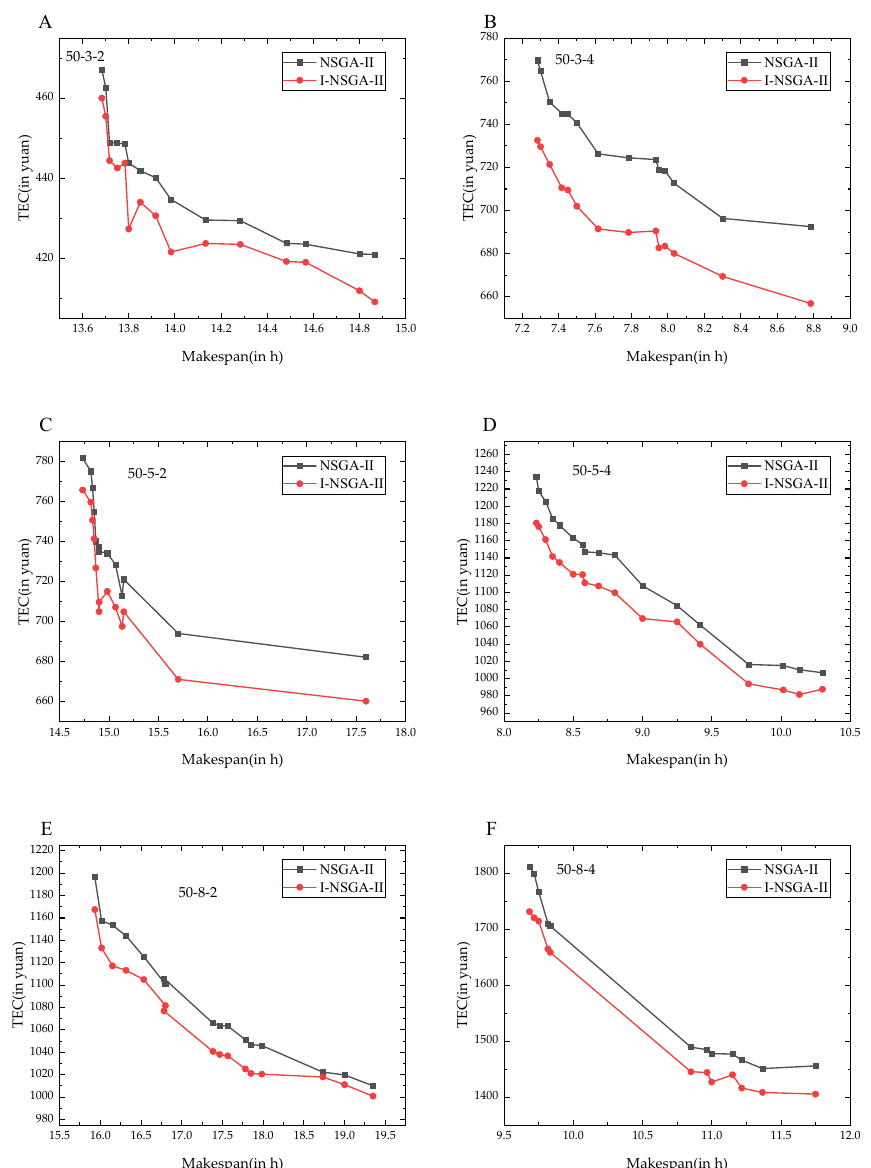
Figure 11. Pareto fronts found by each algorithm for 50-job instances.